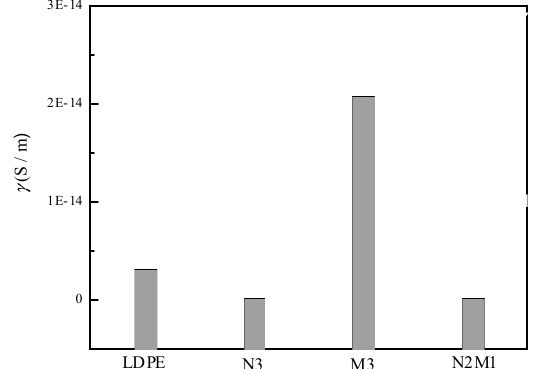
Figure 10. Electrical conductivity of neat LDPE and ZnO/LDPE composites.